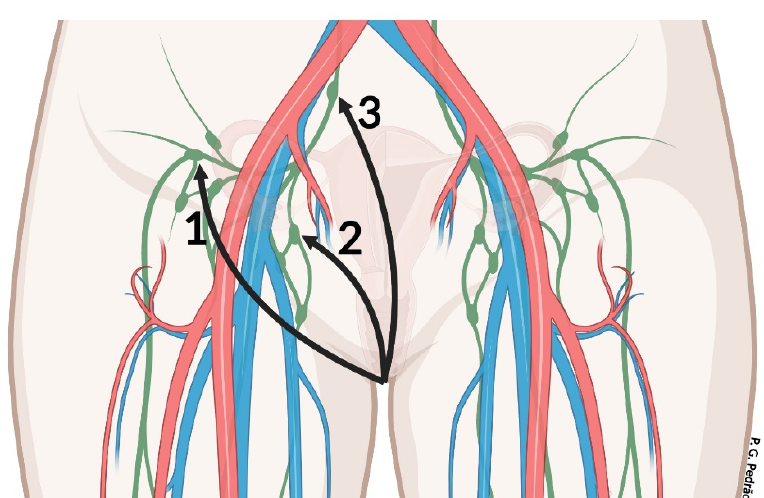
Figure 1. Vulvar anatomy.